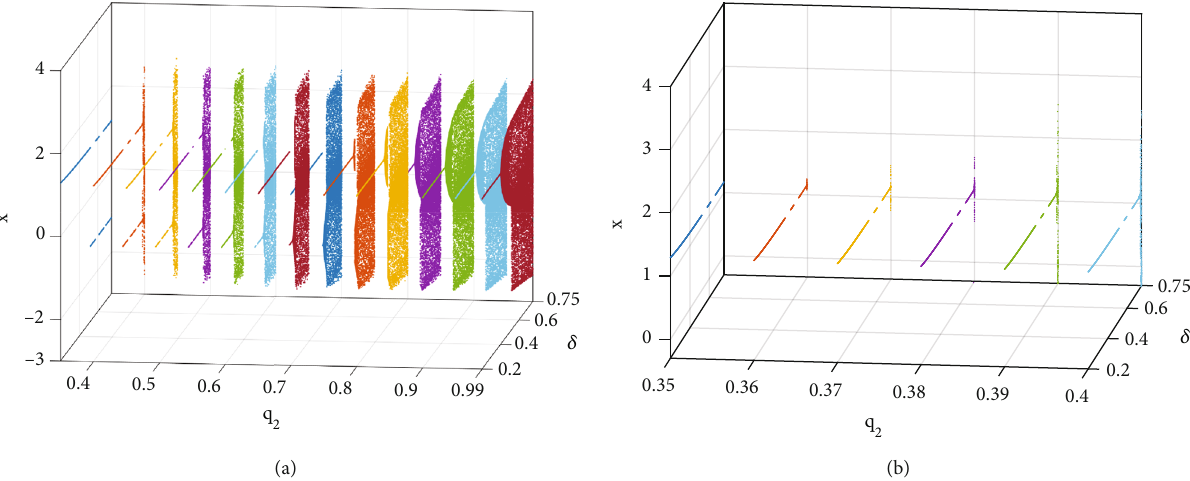
∈ ½ 0 : 35, 0 : 99 (cid:2) . (b) q are varied. (a) q 2 2